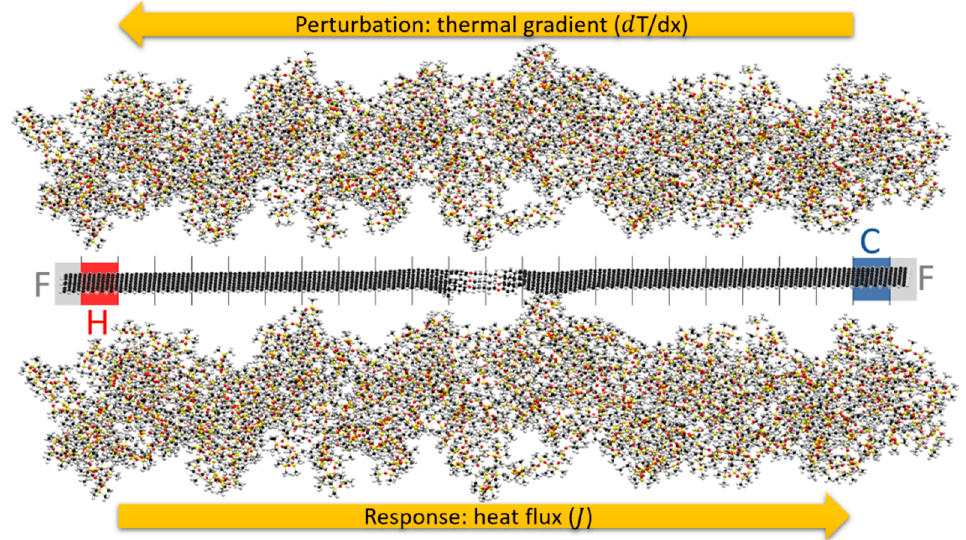
Figure 1. The components of the simulated model. In grey: F as fixed atoms, blue: C as cold reservoir (Nosé–Hoover thermostated region), red: H as hot reservoir (Nosé–Hoover thermostated region), the vertical black lines separate the 22 thermal slabs. Fixed atoms are not counted as thermal slabs.